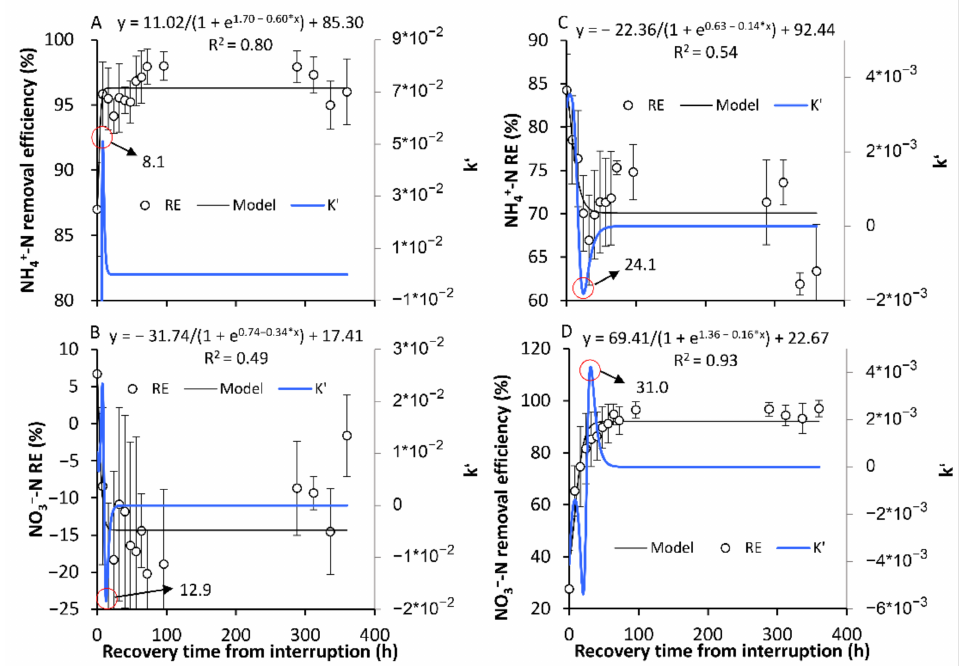
Figure 6. The recovery back to the original stable state (SS) of the removal efficiency of NH 4+ -N and NO 3 − -N after the one-day aeration or no-aeration interruption. ( A , B ) show the recoveries of the original SS of the removal efficiency of NH 4 + -N and NO 3 − -N, respectively, in the AE-D reactors; ( C , D ) show the establishment of the original SS of the removal efficiency of NH 4 + -N and NO 3 − -N, respectively, in the AN-D reactors. The red circle is the position of the inflection point, and the number indicated by the arrow is the corresponding time of the inflection point. (sample number: